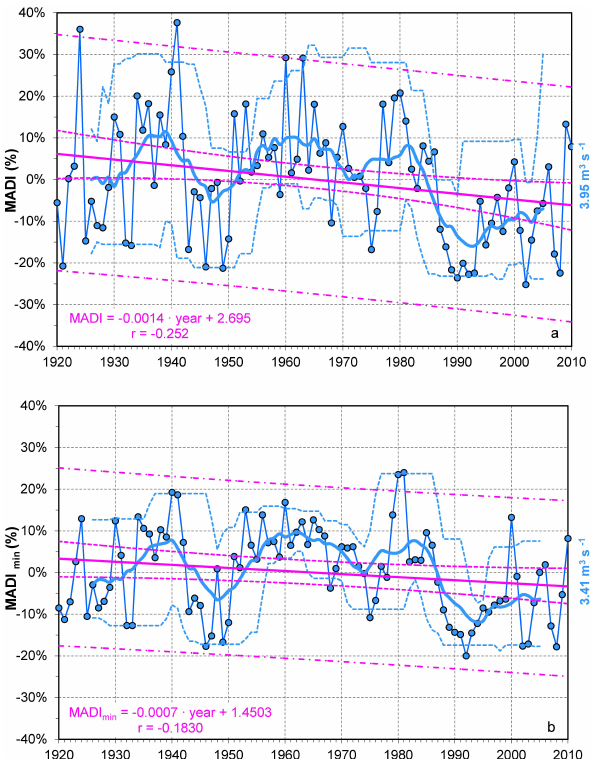
Fig. 6. (a) MADI time series; (b) MADI min time series. Key to symbols: continuous magenta line=linear trend of the whole time series (equation and coefficient of correlation in the lower left cor- ner); dashed magenta lines=95% confidence interval of the ex- pected mean value; dash-dotted magenta lines=95% prediction in- terval of the expected value;continuous thick line=11-yr moving average centred on the sixth year;dashed lines=11-yr moving per- centiles of 5th and 95th centred on the sixth year; number on right side of the graphs=absolute mean value of the whole time series.